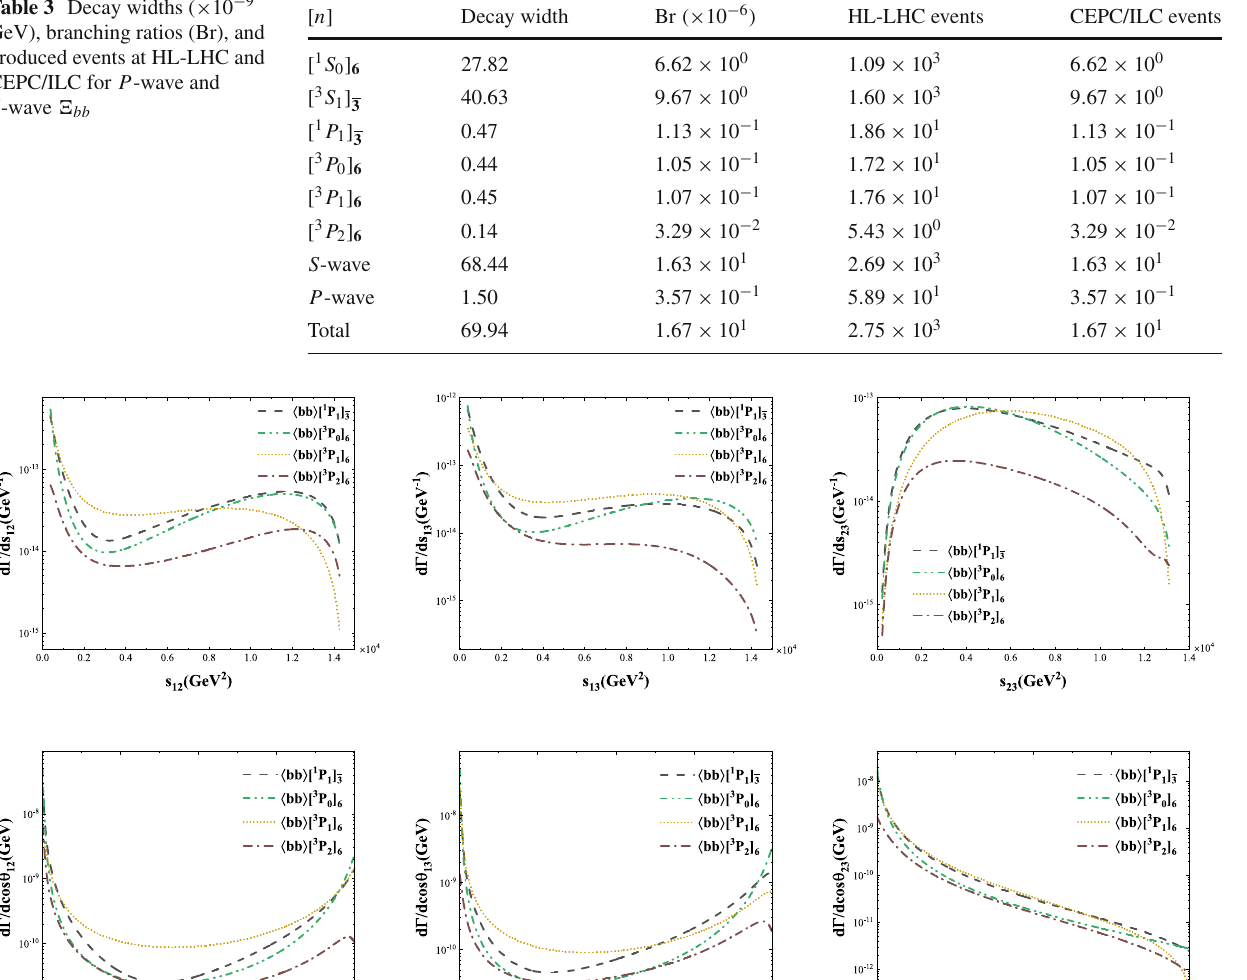
Table 3 Decay widths ( × 10 − 9 GeV), branching ratios (Br), and produced events at HL-LHC and CEPC/ILC for P -wave and S -wave (cid:2)